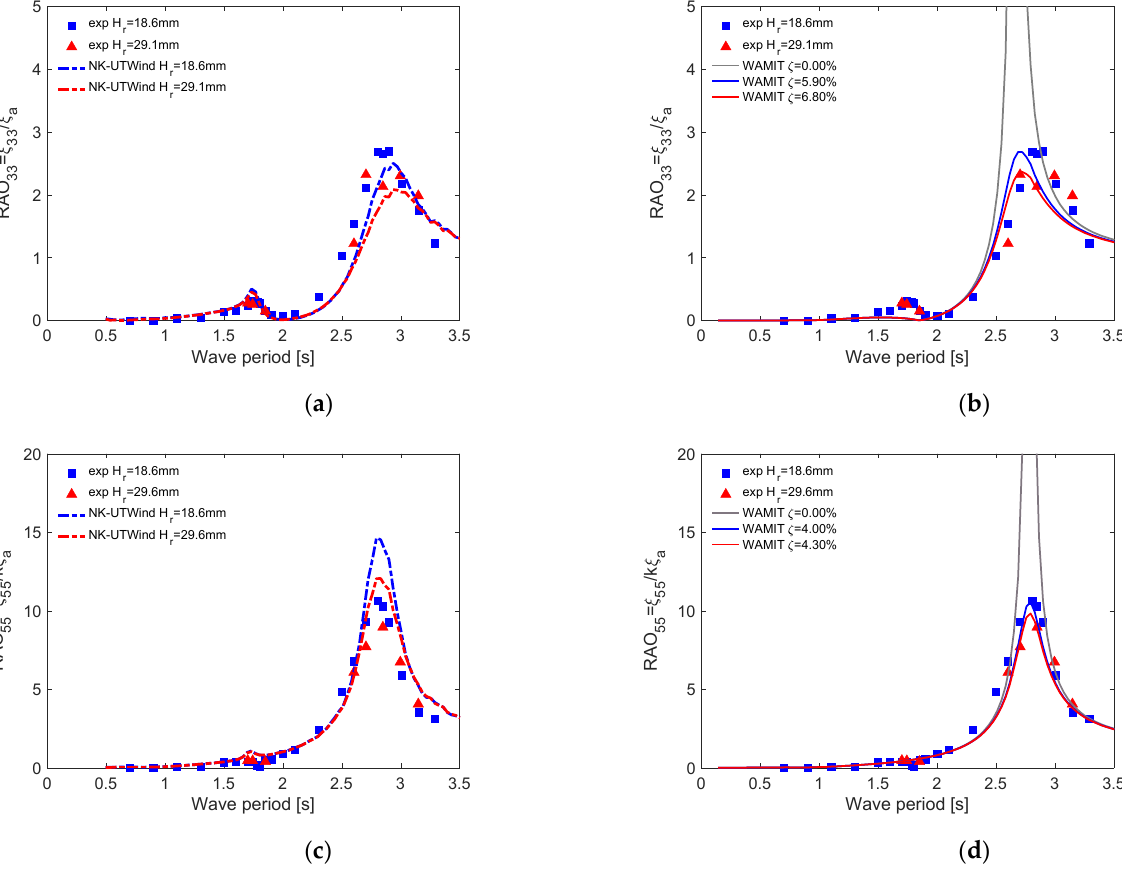
Figure 12. Response amplitude operator (RAO) result comparisons between the experiment and numerical calculations for the Plate model and different wave heights: ( a ) heave, NK ‐ UTWind, ( b ) heave, WAMIT, ( c ) pitch, NK ‐ UTWind, and ( d ) pitch, WAMIT code calculations.